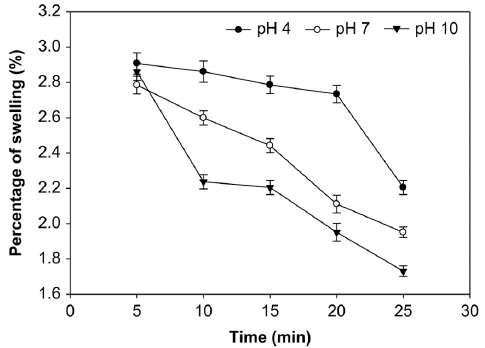
Figure 12. The effect of time on swelling power at various pH with the starch concentration of 30% ( v / w ).